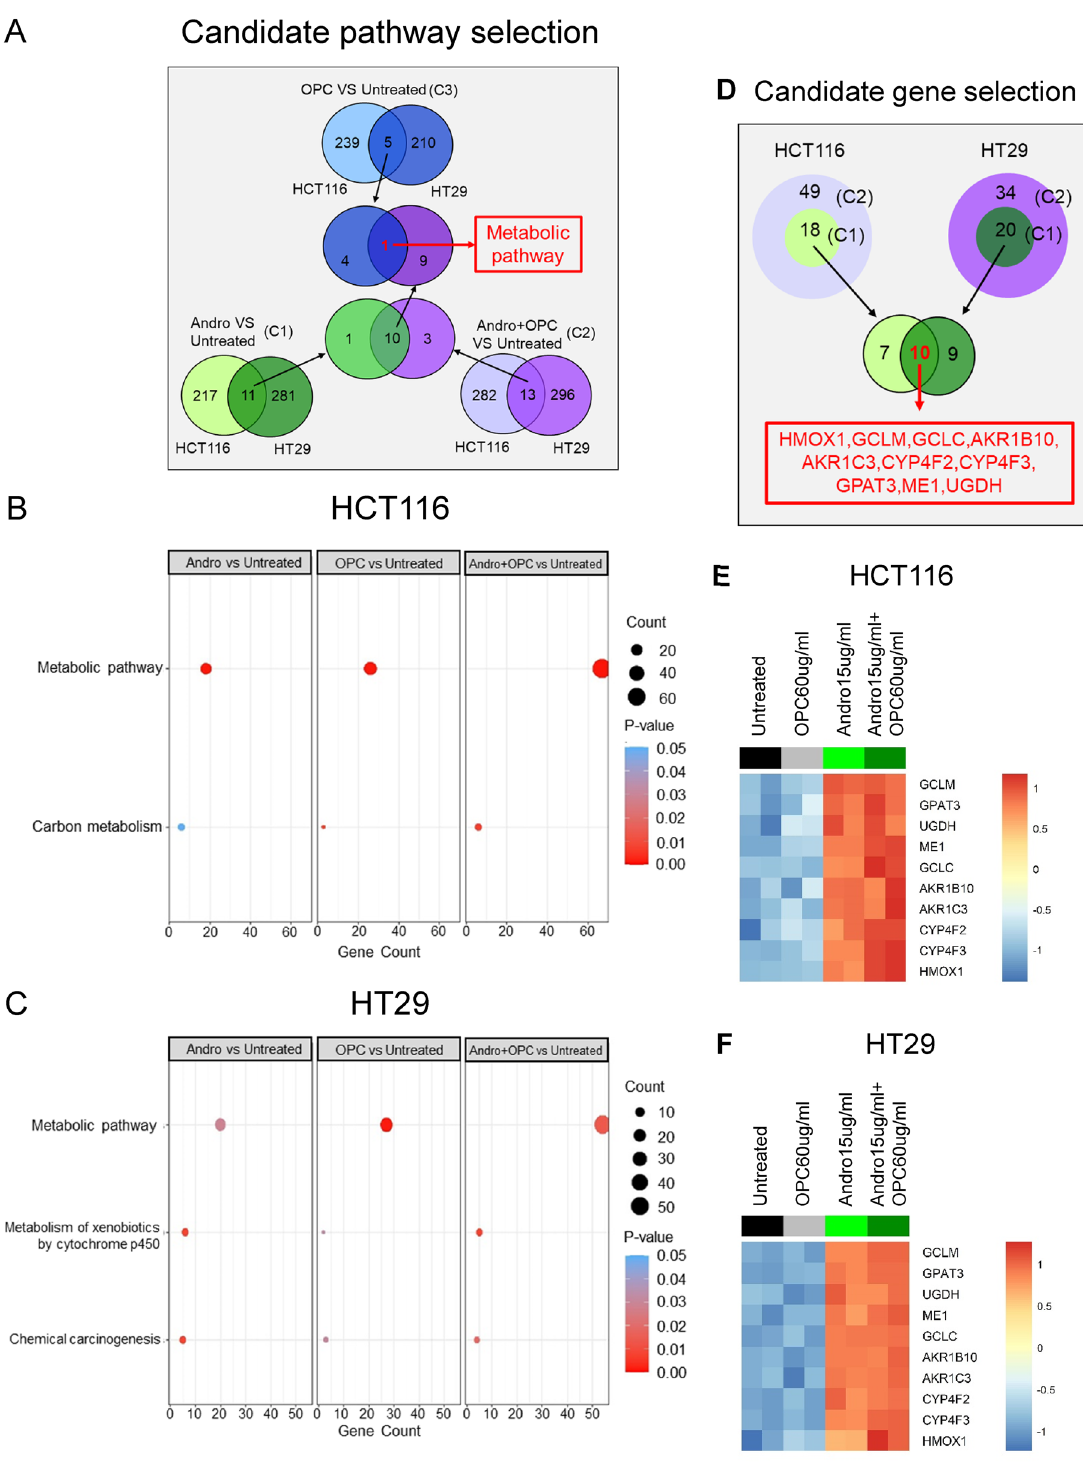
Figure 3. Genomewide transcriptomic profiling analysis. ( A ) Venn-diagram showing the number of dysregulated pathways in both cell-lines among different treatment group comparisons. ( B , C ) Dot plot showing the gene count of commonly dysregulated pathway in all comparison in HCT116 cells (B) and HT29 cells (C). ( D ) Venn-diagram showing the selection process of candidate genes. ( E , F ) Heatmap showing the expression profile of candidate genes in different treatment groups of HCT116 ( E ) and HT29 cells ( F ). Red to blue colors on the heatmap represent relatively high to low log normalized gene expression